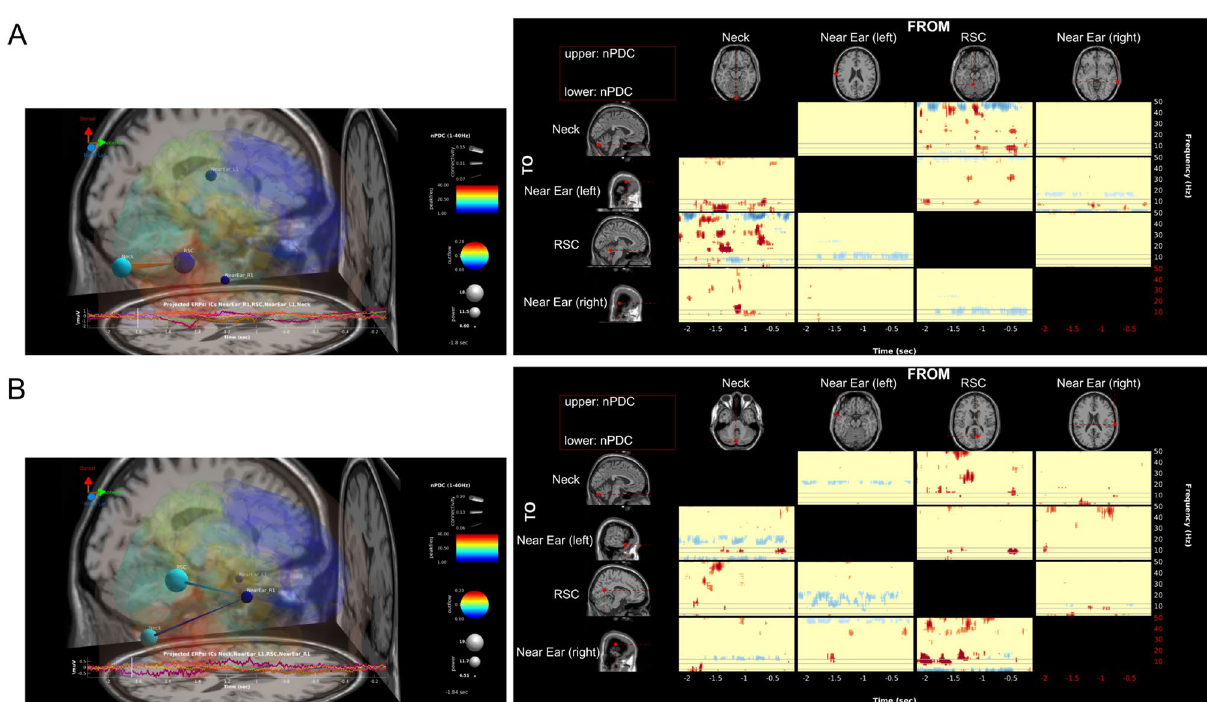
Figure 9. Effective connectivity. The estimated effective connectivity of the four clusters (the RSC, neck, near the ear on the left side, and near the ear on the right side) in two participants. The results indicate that theta activity in the neck cluster has no effect on the